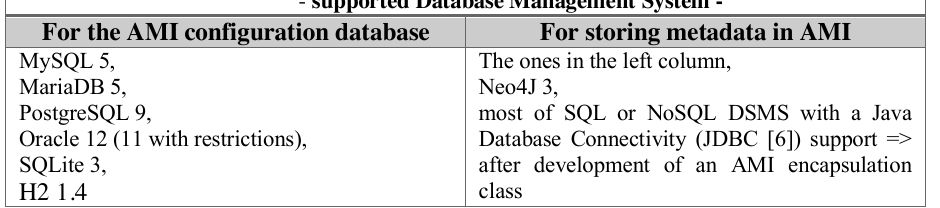
Table 2. Supported DBMS by the AMI ecosystem for the AMI configuration database (at left) and for storing metadata (at